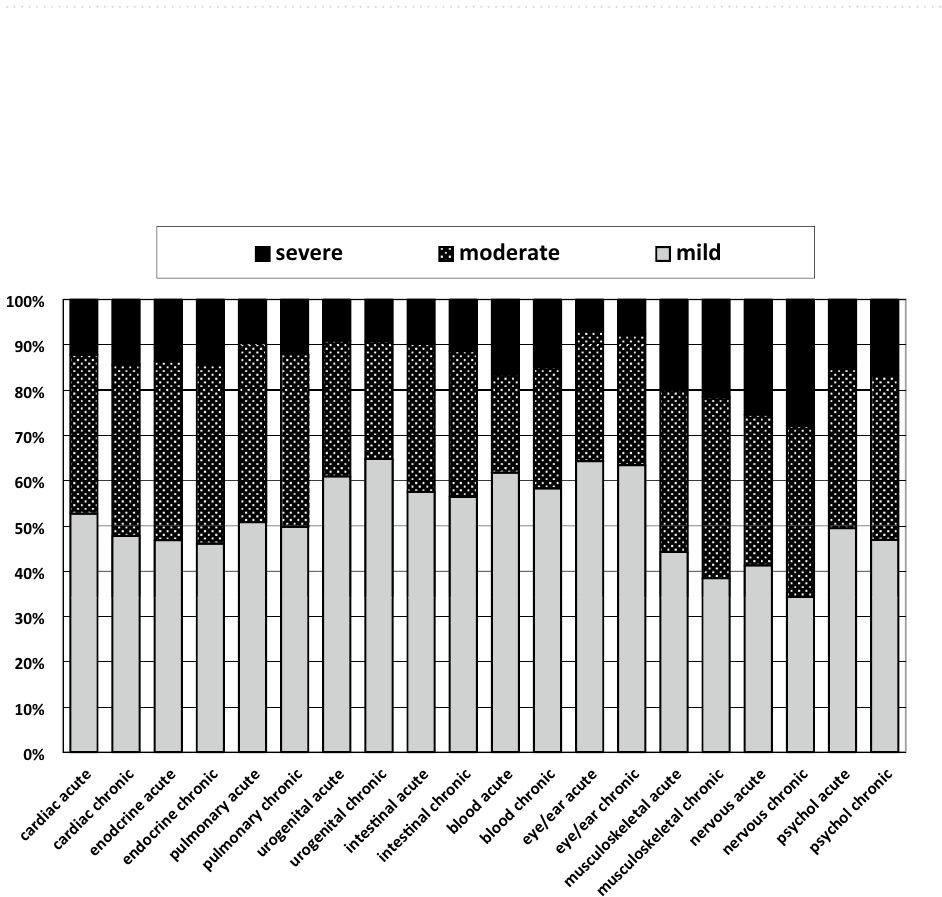
Figure 2. Severity ratings for acute and chronic problems by body